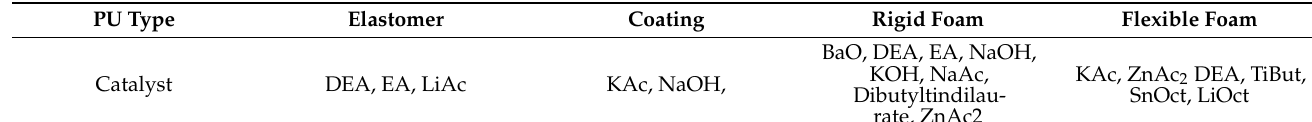
Table 5. Glycolysis of Various Polyurethane